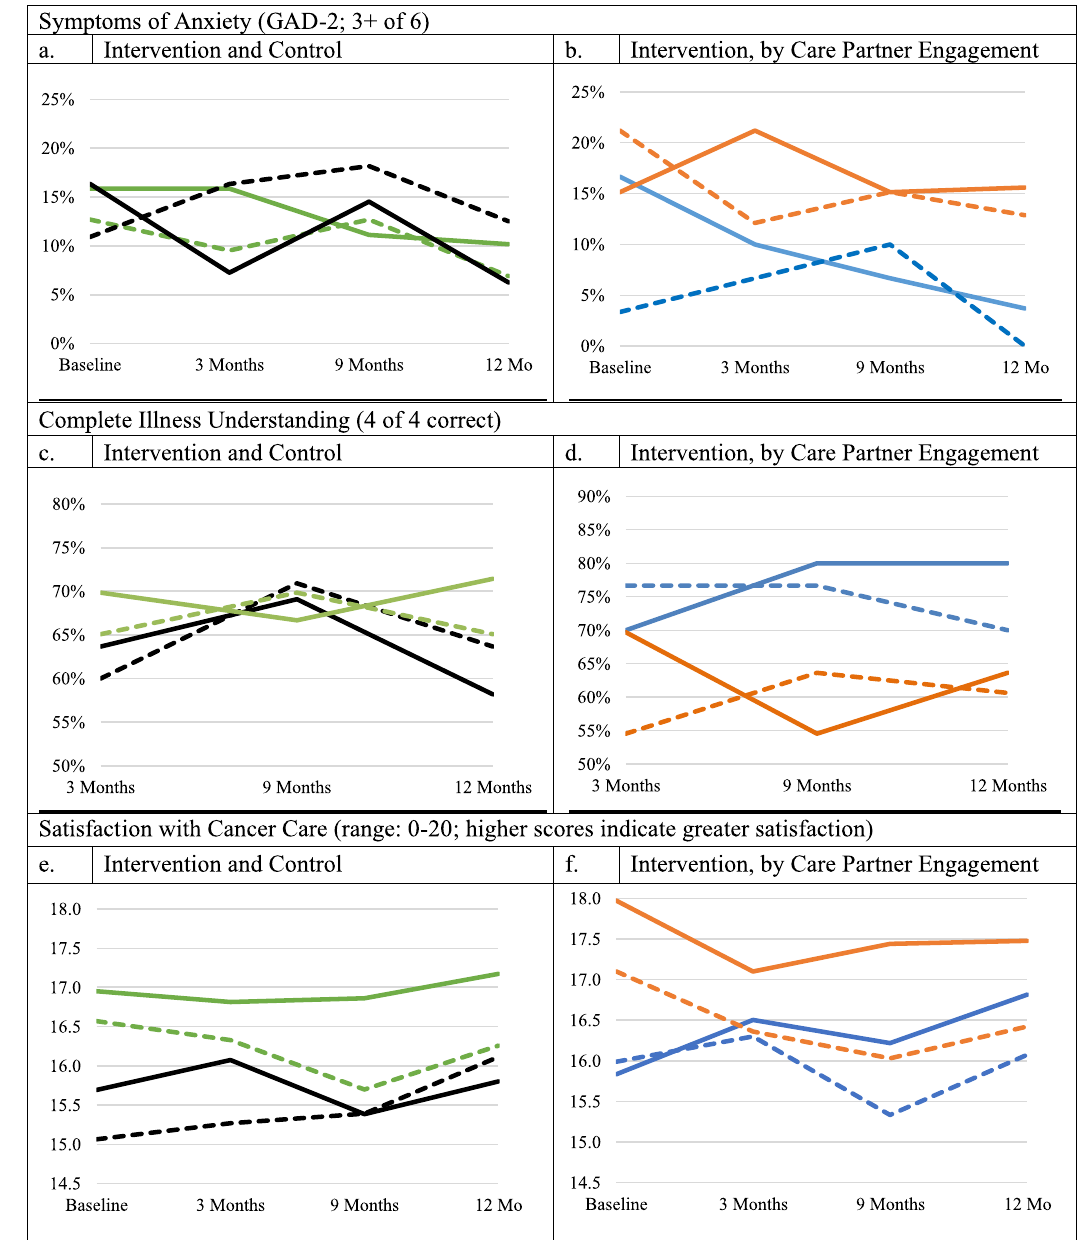
Fig. 2 Between group differences in patient and care partner-reported outcomes. a , c , e Solid black line — Control Patient Dashed black line — Control Care Partner. Solid green line — Intervention Patient. Dashed green line — Intervention Care Partner. b , d , f Solid blue line — Patient with Engaged Care Partner. Dashed blue line — Engaged Care Partner. Solid orange line — Patient without Engaged Care Partner. Dashed orange line — Nonengaged Care Partner. Symptoms of anxiety refer to a cutpoint of 3 + on the GAD-2. Illness understanding ranges from 0 to 4 with higher scores indicating greater illness understanding: we compare participants with ratings of “ 4 ” , re fl ecting “ complete illness understanding ” with all others. Satisfaction with cancer care is measured using the FAMCARE (range: 0 – 20) with higher scores re fl ecting greater satisfaction. Intervention versus control group outcomes: N = 118 ( n = 63 intervention, n = 55 control). Intervention group outcomes, strati fi ed by whether the care partner accessed MyChart: N = 63 ( n = 30 with an engaged care partner, n = 33 without engaged care